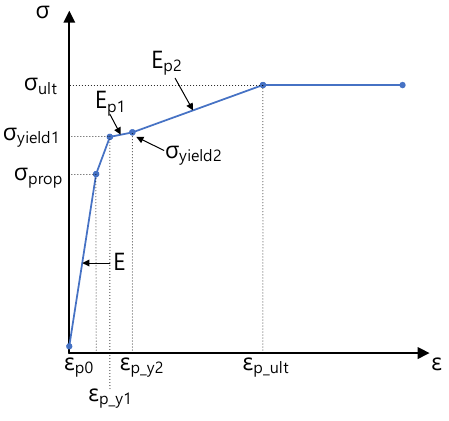
Figure 2. Geometry and corresponding finite element modeling of flange joints.